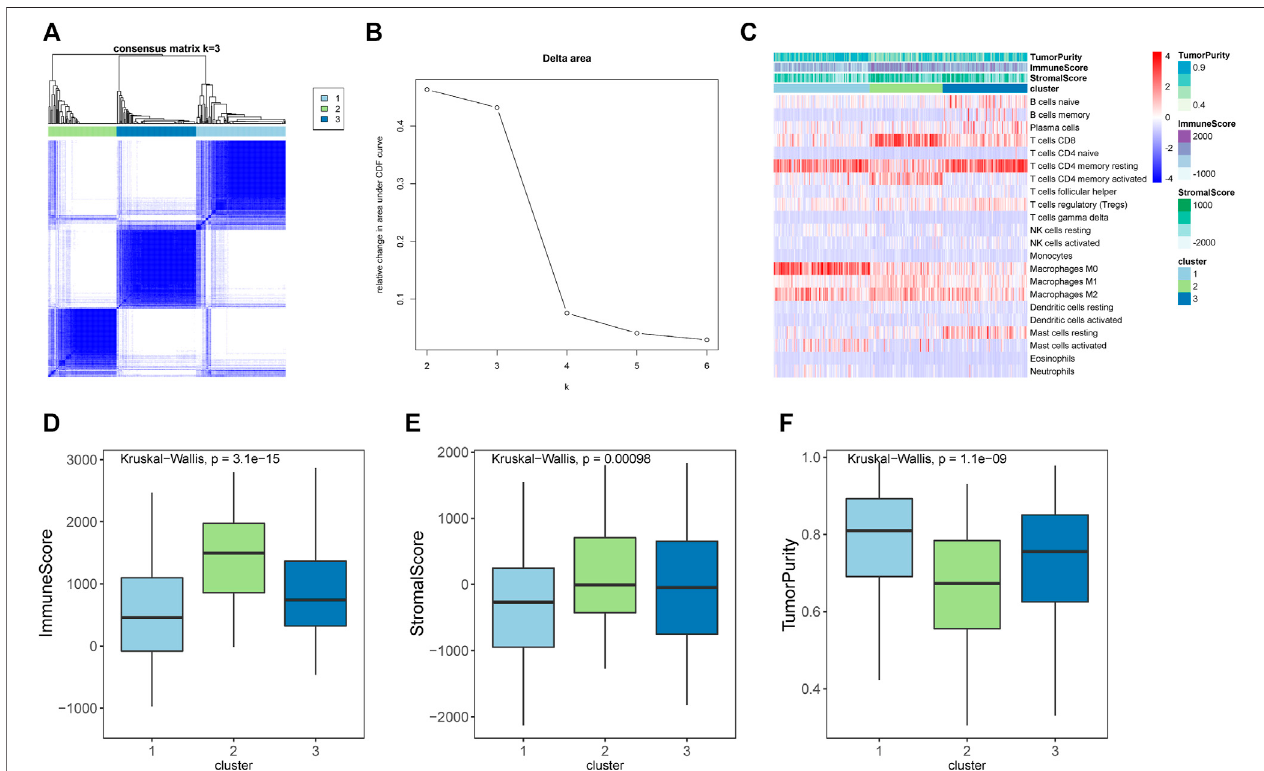
FIGURE2| Immunesubtypesinstomachadenocarcinomas. (A) Heatmapshowedtheresultsofconsensusclusteringanalysis,inwhichsamplesweredividedinto three clusters. (B) Deltadiagramshowedthe clusterswithunderarea. (C) Heatmap showed theimmune in fi ltrationpattern ofthreeimmuneclusters. (D – F) Theimmune score, stromal score, and tumor purity of three